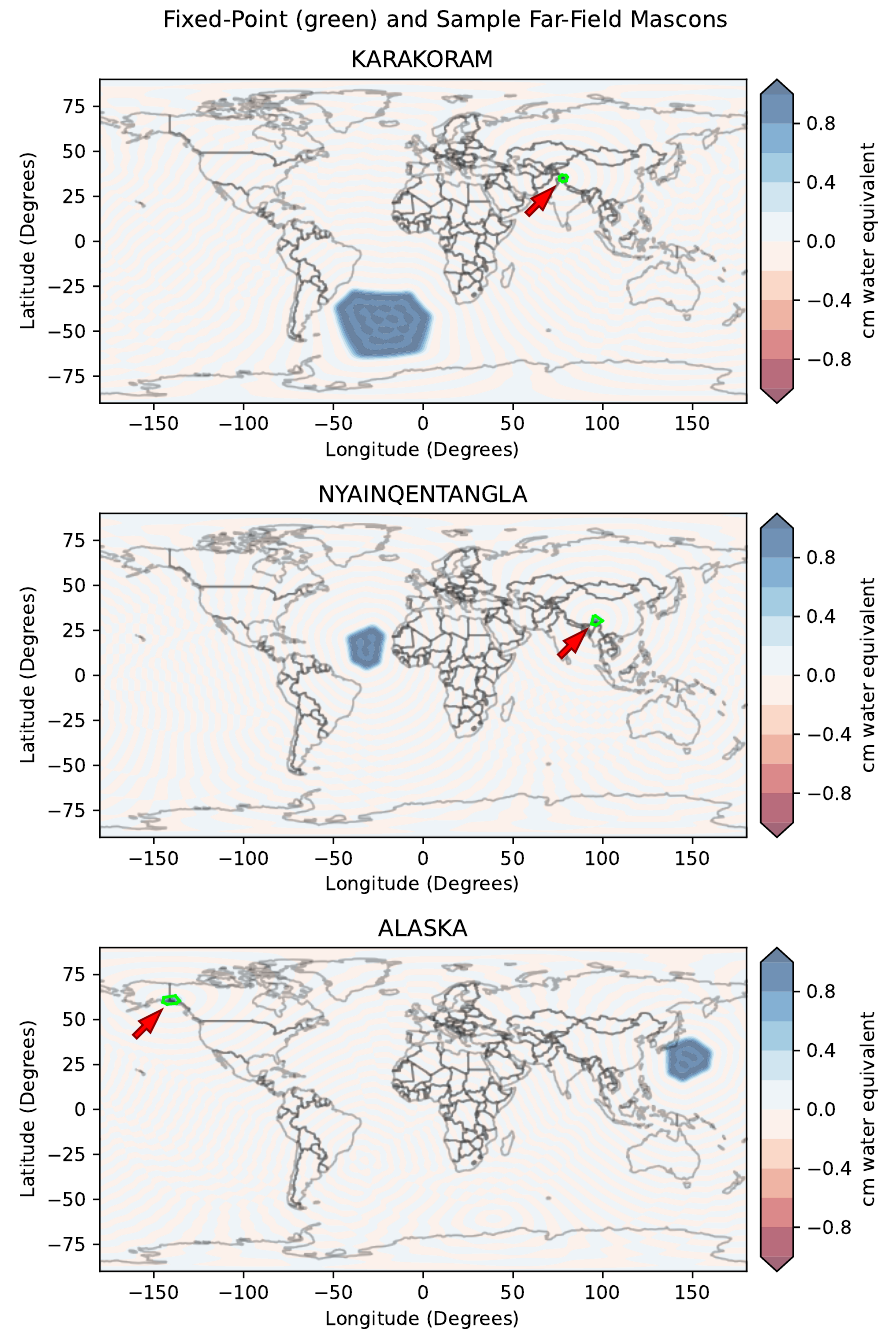
Figure 2. The harmonic representation of sample mascons for the three configurations. The polygon corresponding to the fixed point on the region of interest is highlighted by a green outline, and indi- cated by the red arrow. A randomly selected sample far-field mascon (positive blue signal) is shown for each configuration. All other mascons are set to zero for clarity. As shown, the far-field mascons are much larger, in order to reduce the number of degrees of freedom and the computational cost of the global fit. However, the global configuration captures all expected and unanticipated far-field signals, and prevents the divergence of the sensitivity kernel around the boundaries of the mascon configurations. The mass balance of the region of interest is derived from the smaller mascons given by the fixed points (red arrow), and the larger far-field mascons account for other sources of mass change to minimize